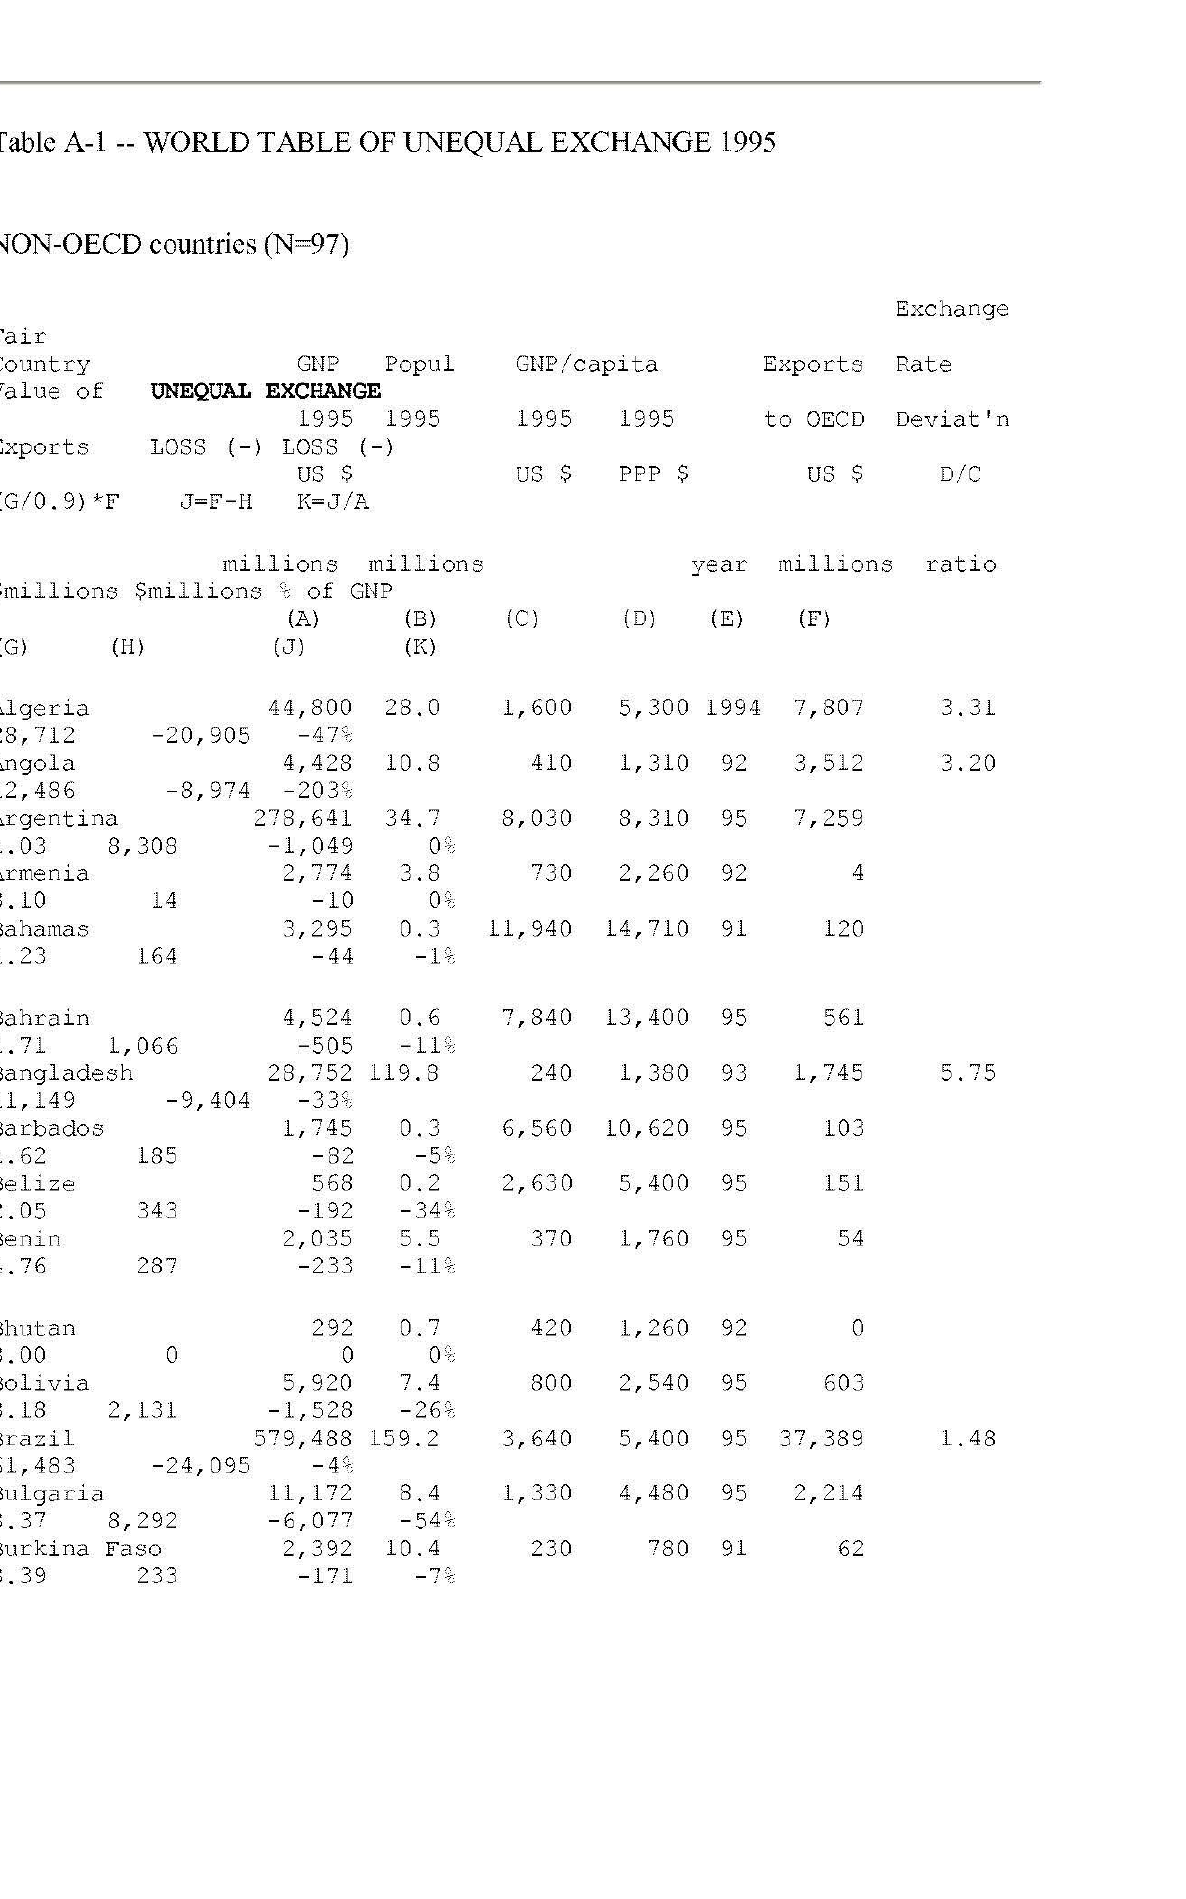
Table A-l -- WORLD TABLE OF UN EQUAL EX CHANGE 1995